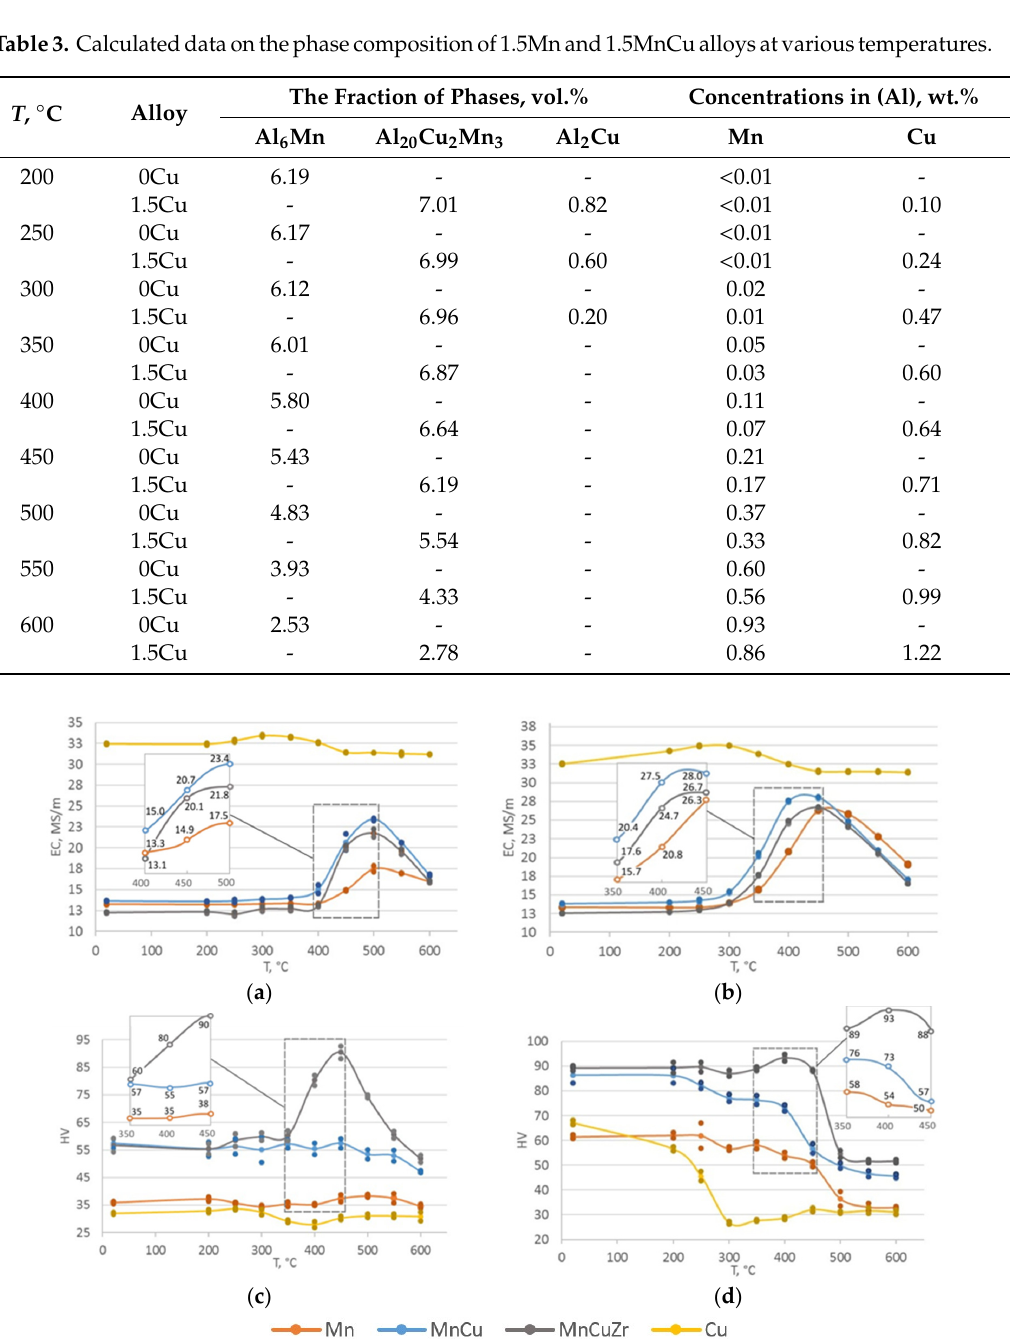
Figure 2. Electrical conductivity ( a , b ) and hardness ( c , d ) and vs. temperature curves for experimental alloys: ( a , c ) ingots and ( b , d ) cold rolled sheets. A measurement error for SEC values: ± 0.22 MS / m for as-cast samples and ± 0.08 MS / m for rolled samples. A measurement error for hardness values: ± 2 HV for as-cast and rolled samples.